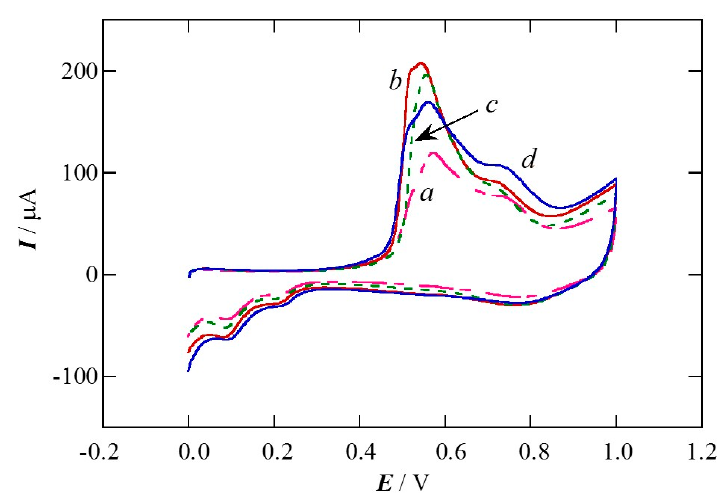
Figure 7. CO stripping curves for the different Pt ‐ Ru(Cu)/C electrocatalysts obtained after different times of spontaneous deposition of Ru species following the synthesis sequence iii : 10 (curve a ), 20 ( b ), 30 ( c ) and 50 ( d ) min. Sweep rate 20 mV s − 1 .